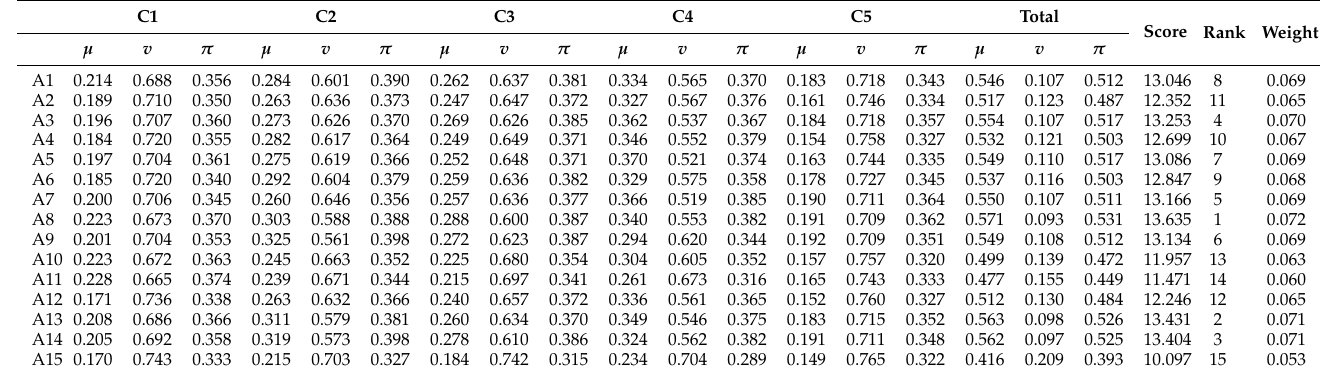
Table A1. Complete SF-AHP results.